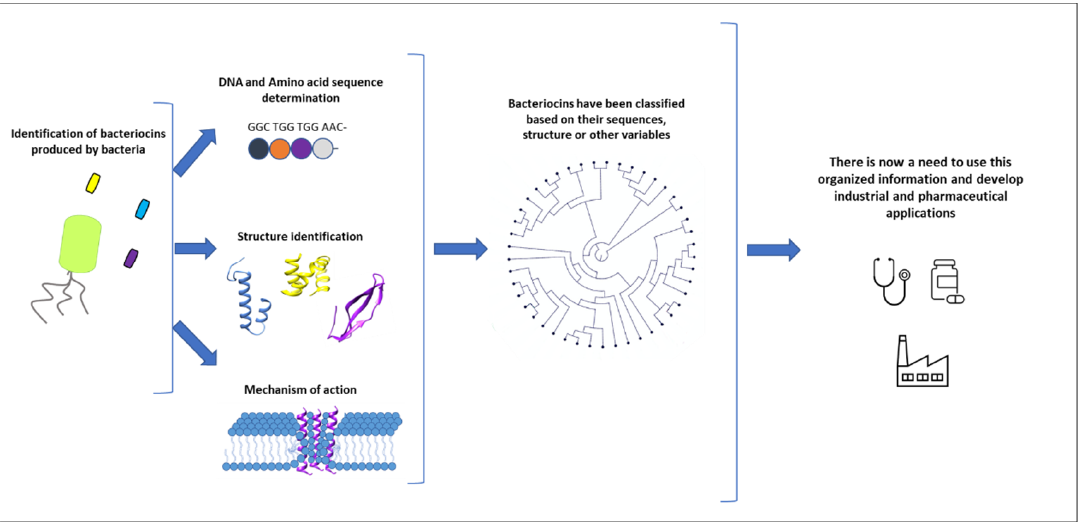
Figure 1. Numerous bacteriocins have been studied by various research groups. When a new bacteriocin is identified, the key elements to determine are its sequence, its three-dimensional structure, and its mechanism of action. Different classifications have been proposed based on this information. However, only a few applications have been explored and brought to market so far. There is now a need to use this organised information to develop new industrial and pharmaceutical